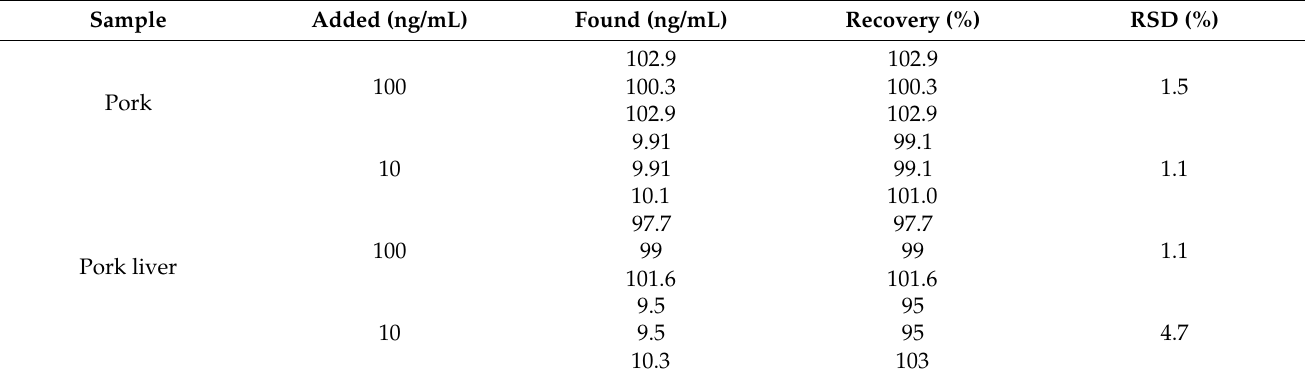
Table 2. Analysis of the immunosensor for ASA in real